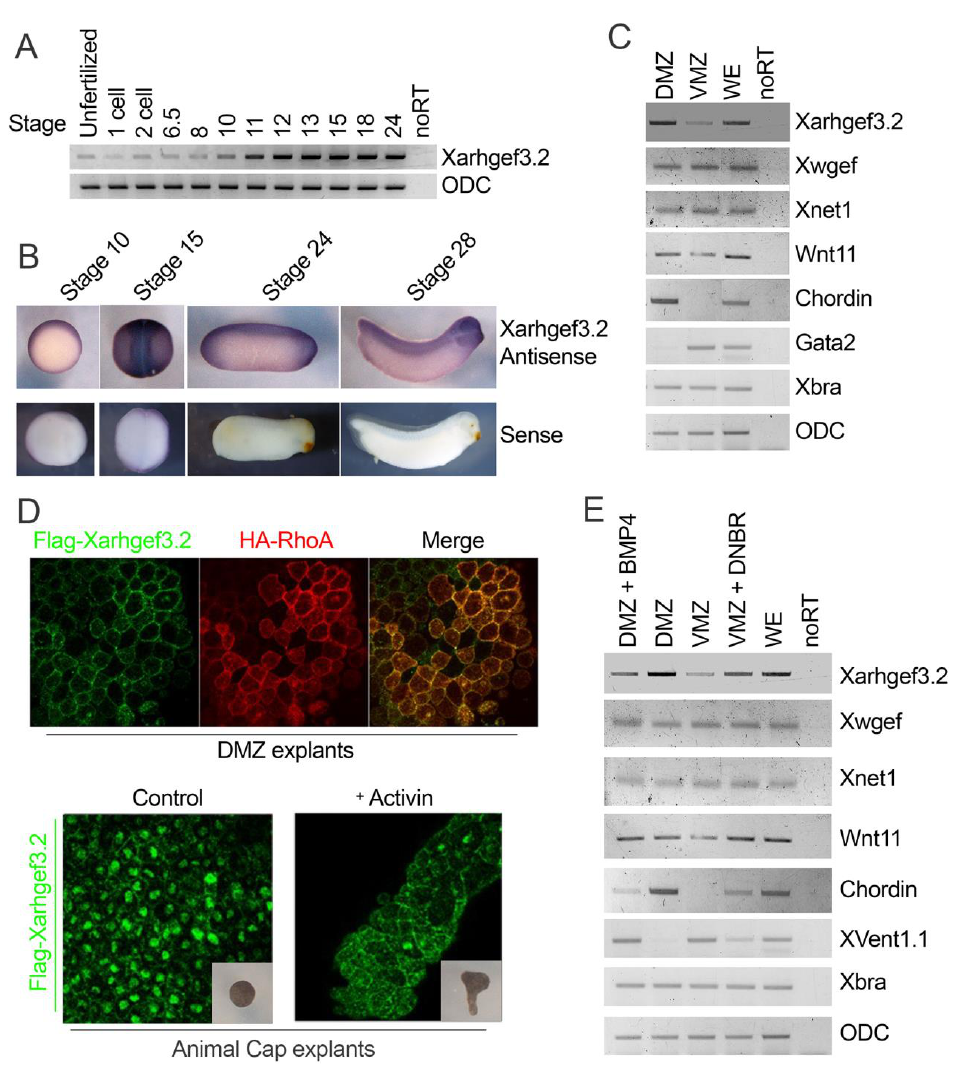
Figure 2. Xarhgef3.2 is expressed in the DMZ at the gastrula stage. ( A ) Temporal expression pattern of Xarhgef3.2 was analyzed using RT-PCR at various developmental stages as indicated. ( B ) Spatial expression of Xarhgef3.2 was analyzed using whole mount in situ hybridization at the indicated stages. Stage 10: vegetal view, dorsal lip on top; stage 15: dorsal view; stages 20 and 28: lateral views. ( C ) RT-PCR confirmed the spatial expression pattern of the indicated gene expression by using each dissected (at stage 10) region of the embryo at stage 12. ( D ) RNAs of Flag-Xarhgef3.2 (100 pg/embryo) and HA-RhoA (100 pg/embryo) were co-injected into the dorsal marginal zone at the four-cell stage. The DMZ explants were dissected at stage 10 and fixed using MEMFA and stained with the anti- Flag and anti-HA antibodies. Localization of Flag-Xarhgef3.2 was analyzed with the DMZ explants using confocal microscopy. ( E ) The BMP4- or DNBR-injected DMZ or VMZ explants were examined using RT-PCR to analyze the expression level of the indicated genes at stage 12 (ventral marker: gata2 and ventx1.1 ; mesoderm marker: xbra ; organizer marker: chrd ; loading control: odc ).